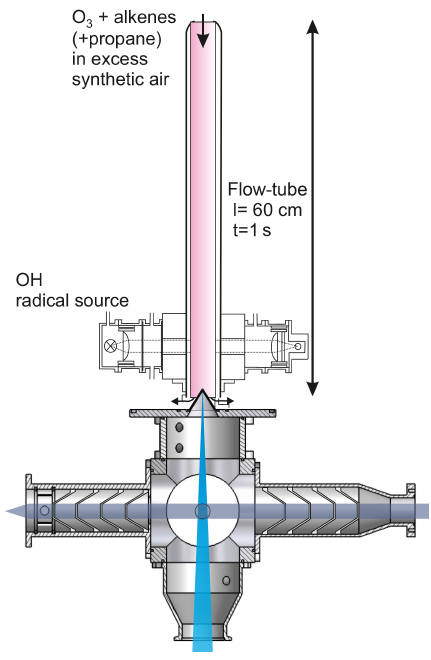
Figure 2. Set-up for laboratory ozonolysis experiments. Reactants are flowed through a 60cm long flow tube (OH radical source) mounted on top of the fluorescence cell (scales of the radical source differs from the scale of fluorescence cell). The cell with the short inlet is shown, but the set-up was the same for the cell with the long